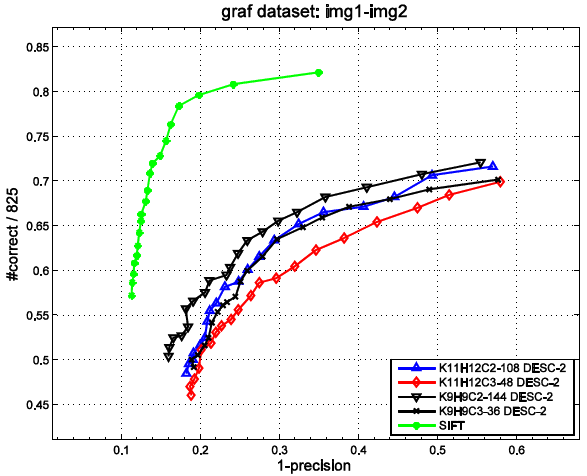
Figure 7. Descriptor performance curves for different pooling